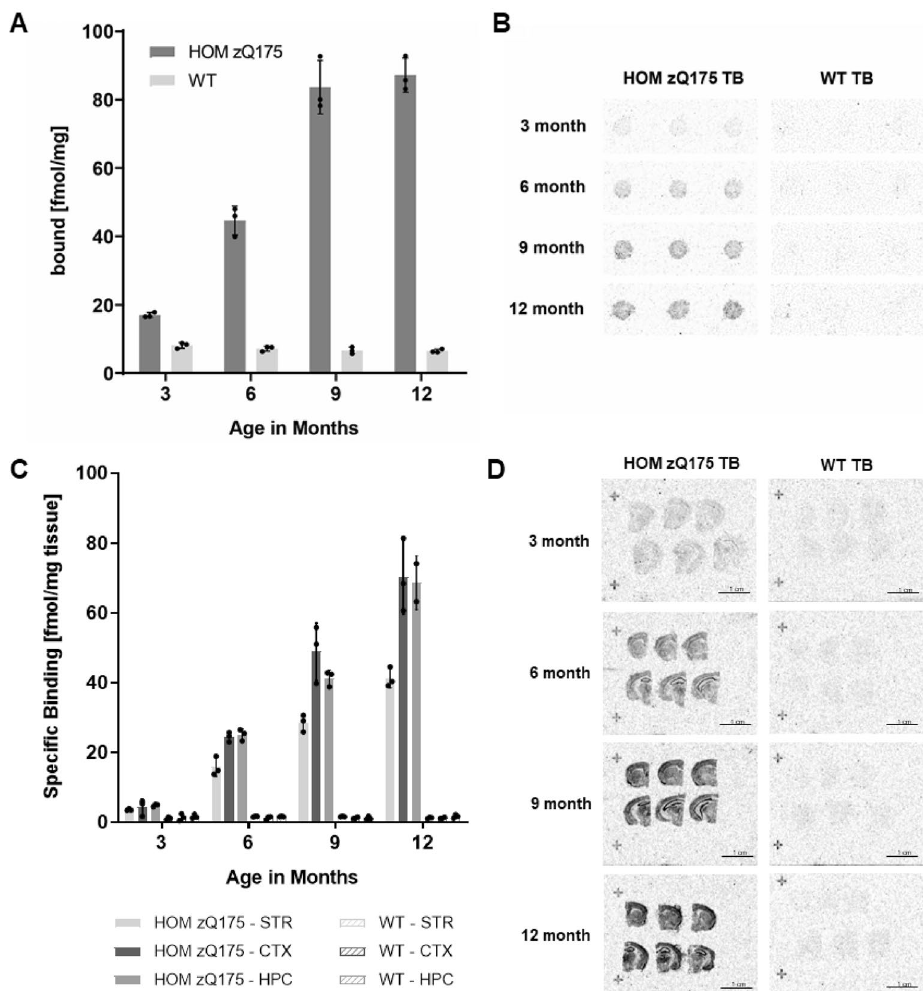
Figure 4. Age-dependent increase of [ 3 H]CHDI-180 binding in HOM zQ175 HD mouse brains. ( A ) Radiometric filter trap assay (RAFTA) showing an age-dependent increase in [ 3 H]CHDI-180 binding to aggregates in brain homogenates of HOM zQ175 HD mice. ( B ) Example images of [ 3 H]CHDI-180 binding in RAFTA. ( C ) In vitro ARG showing an age-dependent increase in [ 3 H]CHDI-180 binding to brain sections of HOM zQ175 HD mice. Specific binding (SB) of 0.5 nM [ 3 H]CHDI-180 in striatum (STR), cortex (CTX) and hippocampus (HPC) of 3-, 6-, 9- and 12-month-old HOM Q175 mice and age-matched WT mice. ( D ) Example images of [ 3 H]CHDI-180 binding. Data are depicted as mean ± SD from a total of n = 3 brain hemispheres per age and